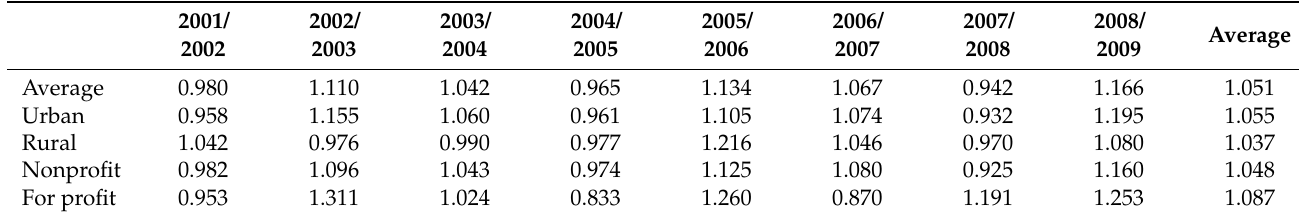
Table 3. Summaries of bootstrapped productivity changes of Malmquist indices.